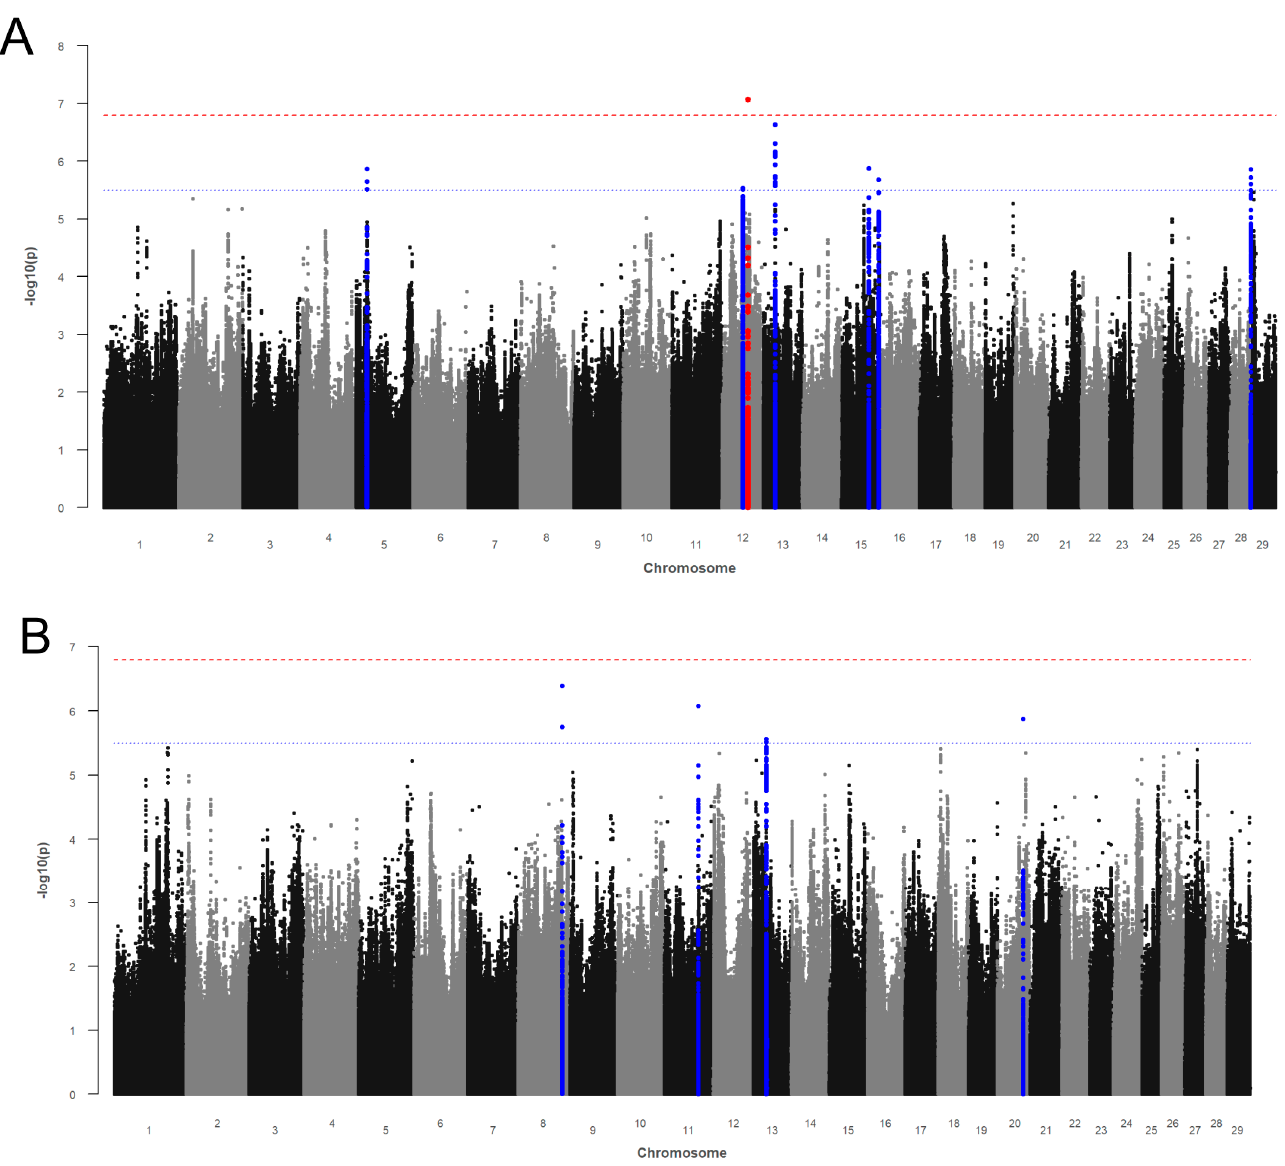
Figure 1. Manhattan plots for − log10 p -values of marker effects for ( A ) calving-to-first service interval (CTFS) and ( B ) non-return 56 (NR56). Markers above the genome-wide significance threshold p Bonf (red dashed line) are highlighted in red and markers above the suggestive significance threshold p Sug (blue dashed line) are highlighted in blue. Markers within a distance of 125 kb up- and downstream of the significantly or suggestively associated SVs are highlighted in red or blue, respectively.